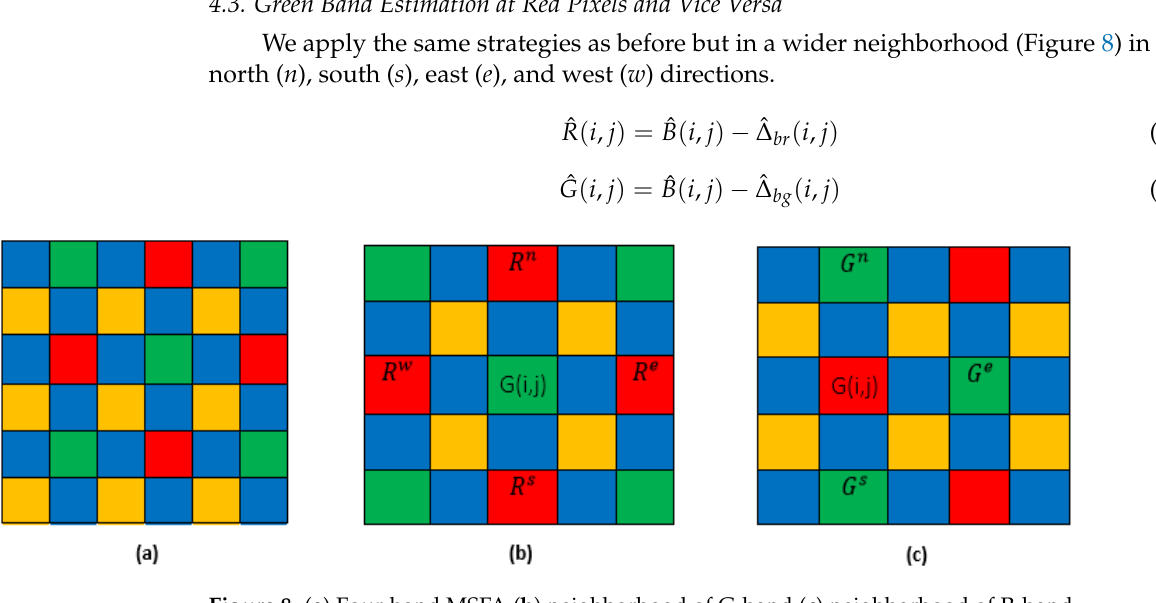
Figure 8. ( a ) Four ‐ band MSFA ( b ) neighborhood of G ‐ band ( c ) neighborhood of R ‐ band.